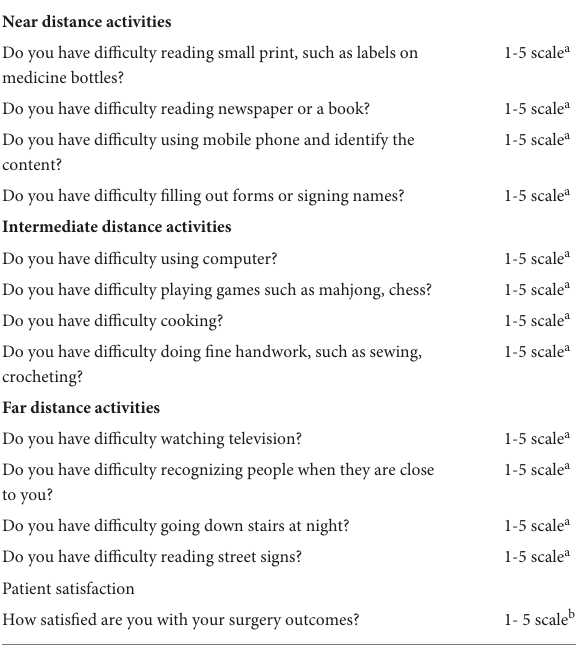
TABLE 2 Questionnaire used in this study to evaluate the quality of life and patient satisfaction.